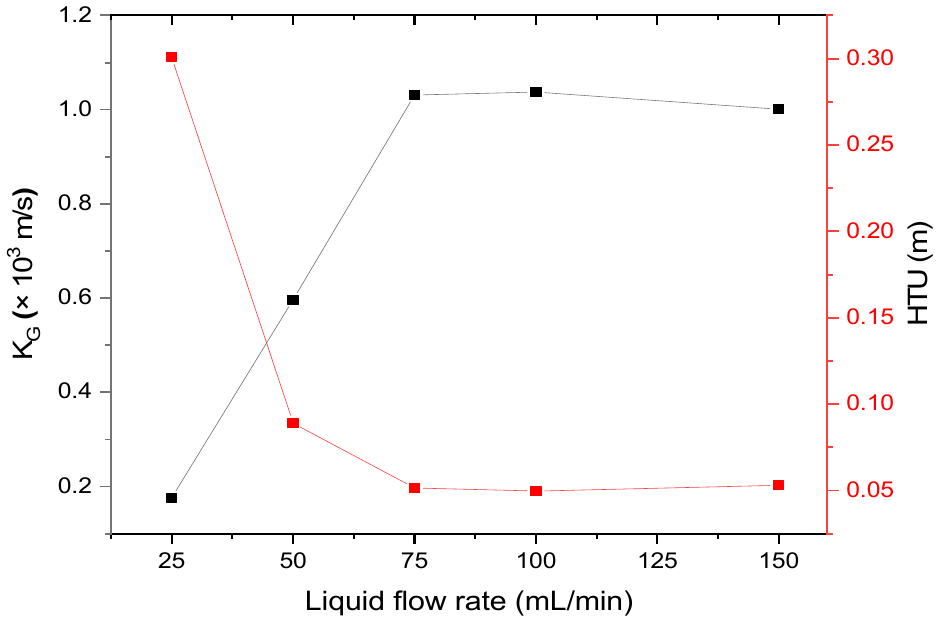
Figure 6. Effect of absorbents on SO 2 overall mass transfer coefficient.